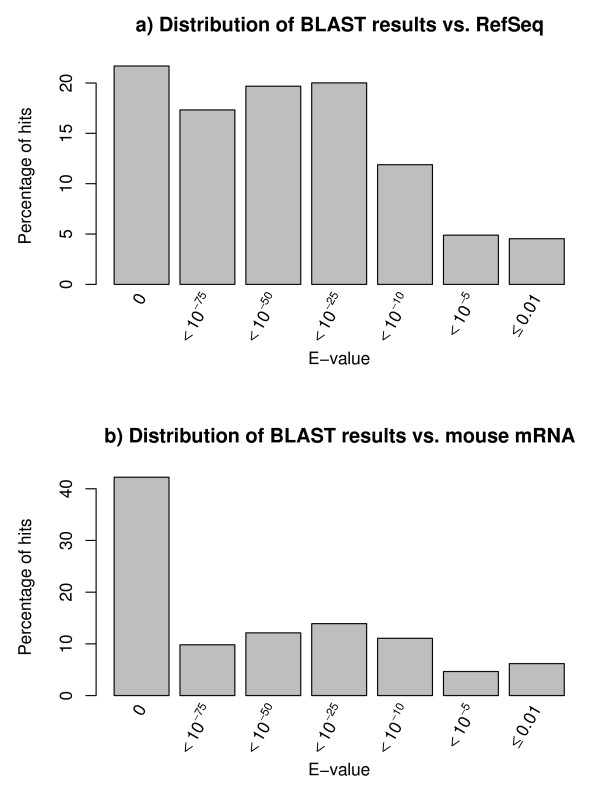
Distribution of the e-values of different BLAST analyses. Distribution of e-values for Ovis aries contigs blasted against the RefSeq protein database (a) or the nonredundant mRNA database restricted to mouse sequences (b).